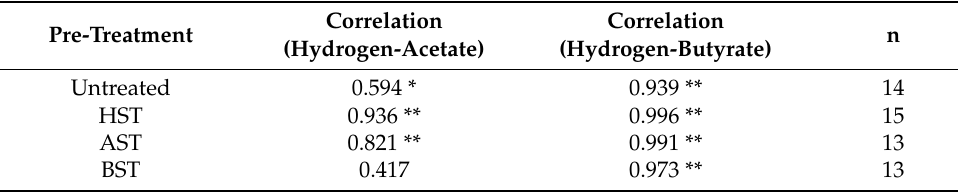
Correlation (Hydrogen-Butyrate)